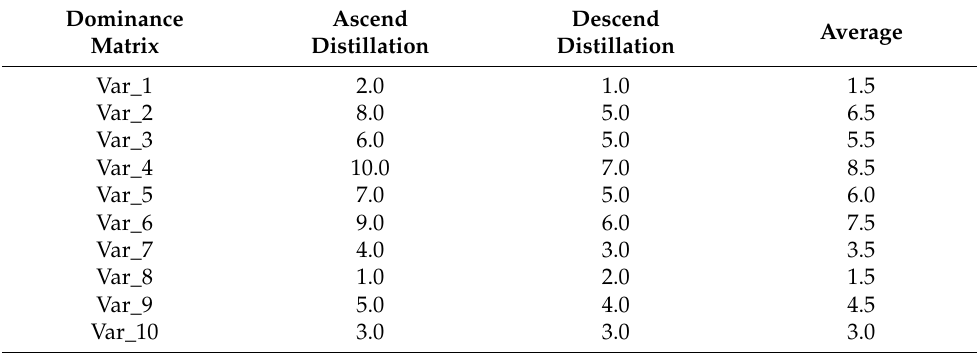
Table 13. Final ranking from the point of view of the surveyed women.